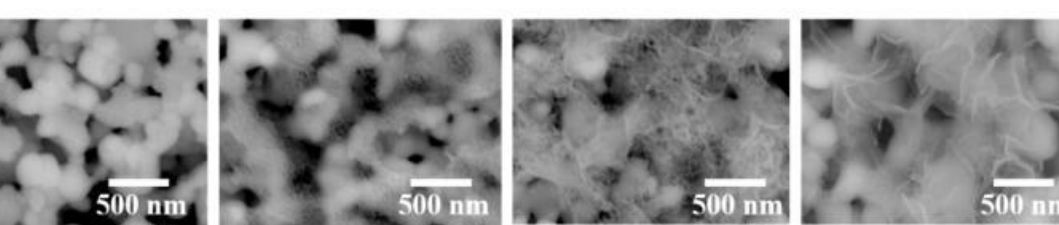
Figure 12. Schematic of the step-wise synthesis process of the catalyst and corresponding SEM im- ages. Reprinted with permission from Ref. [134]. Copyright 2021 Elsevier.